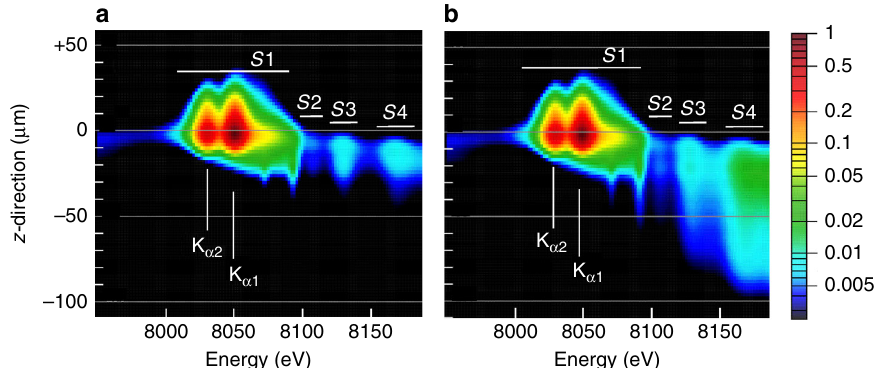
Fig. 8 Effect of hot electron population. Synthetic spatially resolved spectra employing the same plasma parameters but different multiplication factors of the hot electron fraction, a hot electron populations from the ab initio simulation, b hot electron fraction decreased by a factor of